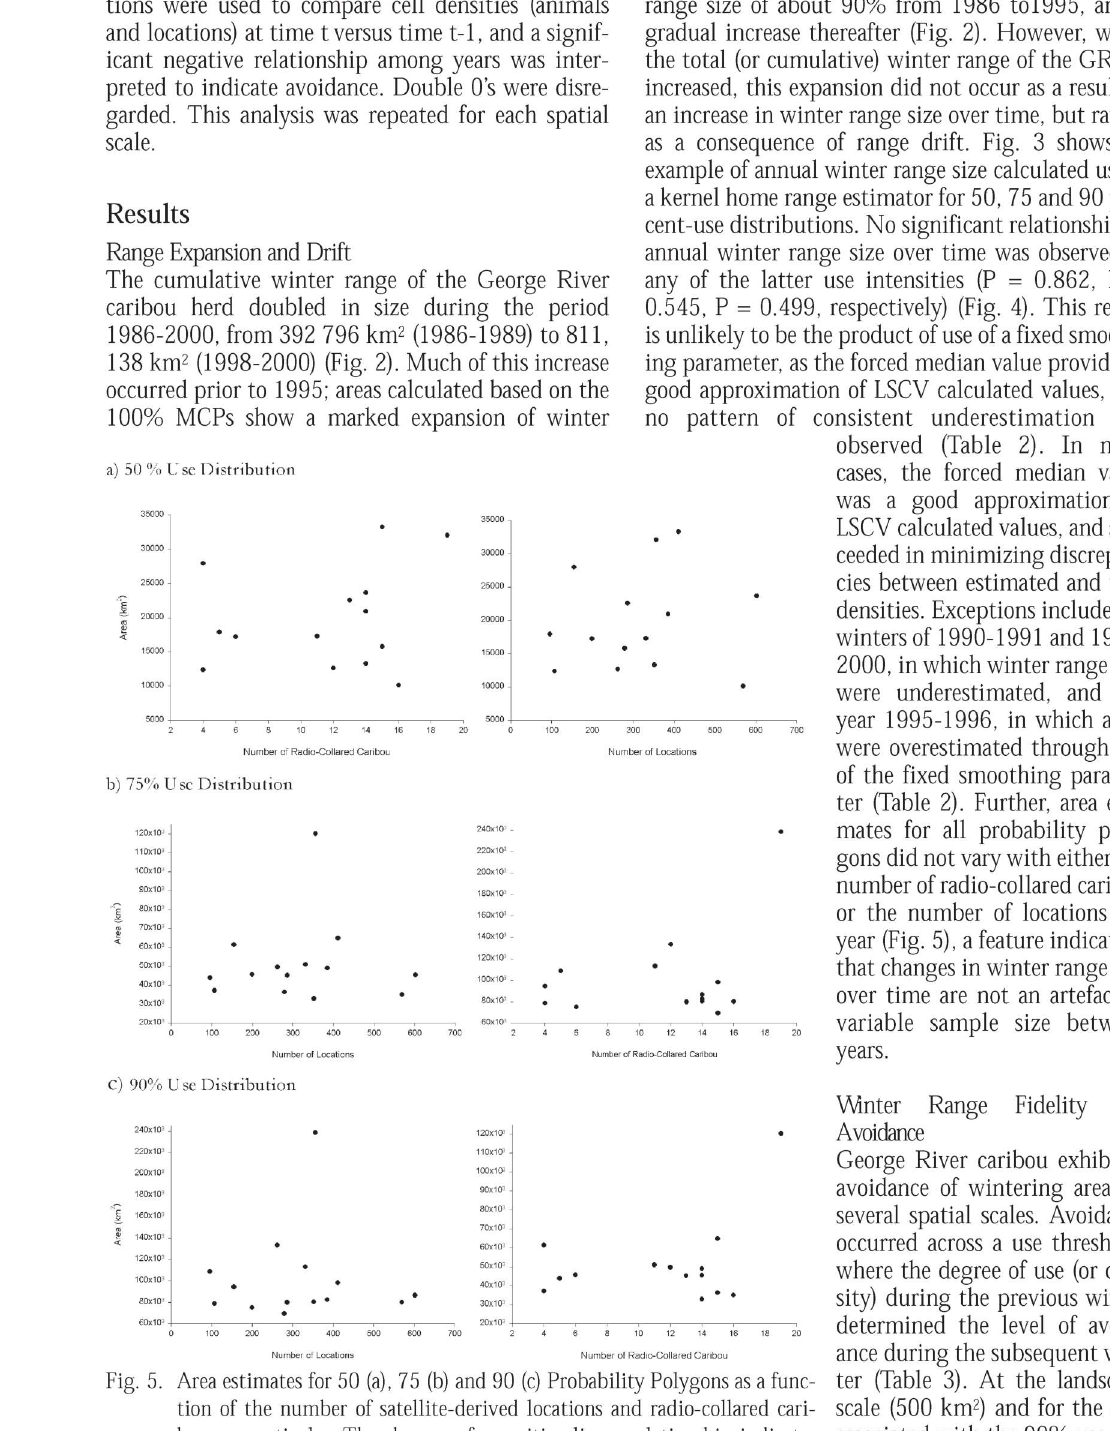
Fig. 5. Area estimates for 50 (a), 75 (b) and 90 (c) Probability Polygons as a func¬ tion of the number of satellite-derived locations and radio-collared cari¬ bou, respectively. The absence of a positive linear relationship indicates that changes in winter range size over time cannot be ascribed to variable sample size between